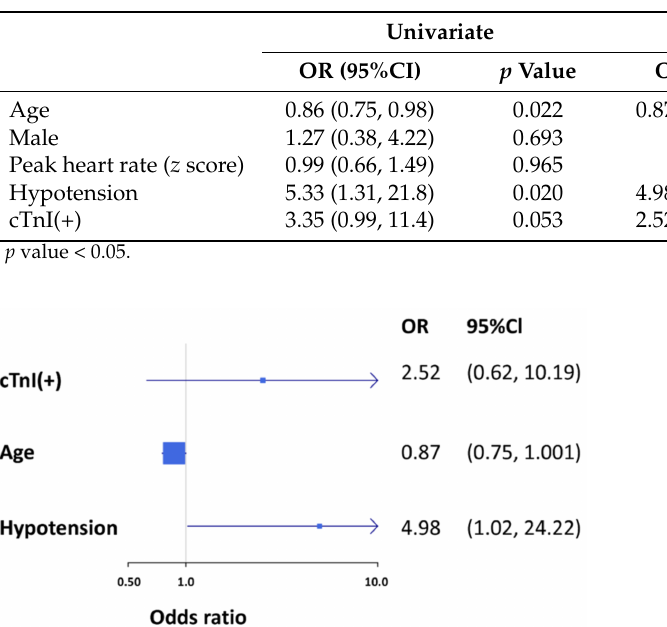
Table 5. Univariate and multivariable logistic regression results for 30-day SVT recurrence.